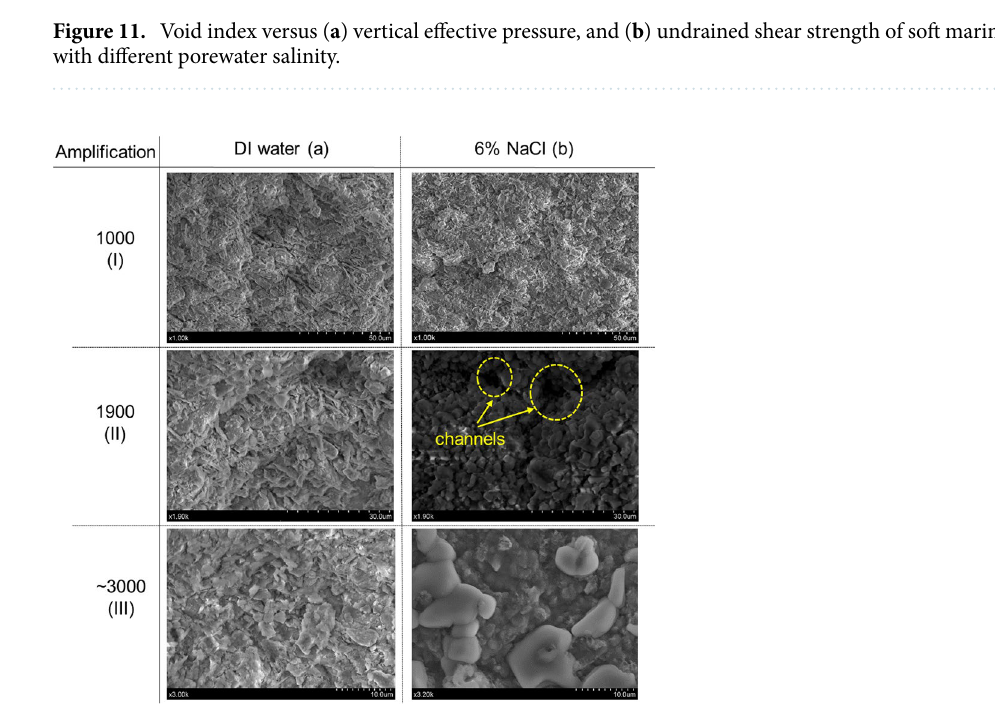
Figure 12. Upscaling SEM images of soft marine clay exposed to ( a ) DI water and ( b ) 6% NaCl